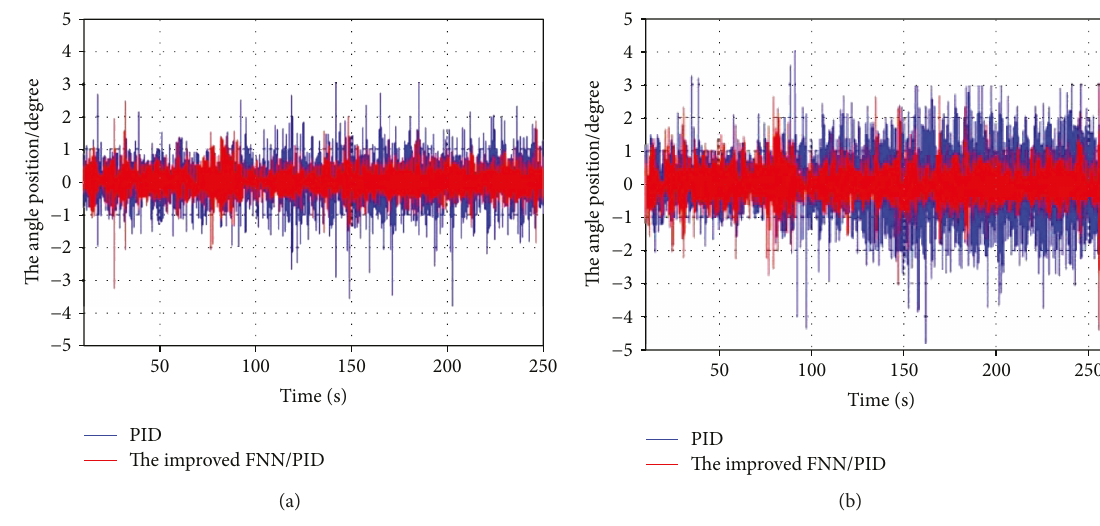
Figure 19: Moving base experiment results: (a) rolling and (b) pitching. Table 4: Result comparison among three methods under dynamic levelling